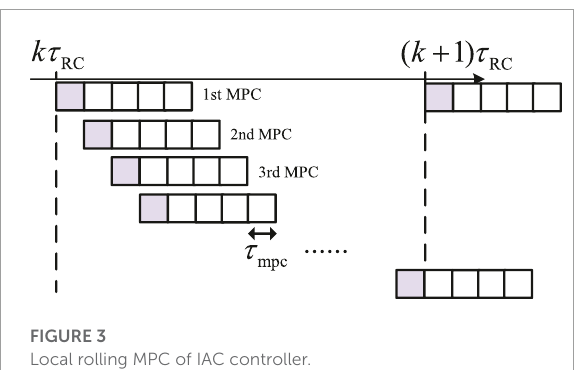
FIGURE 3 Local rolling MPC of IAC